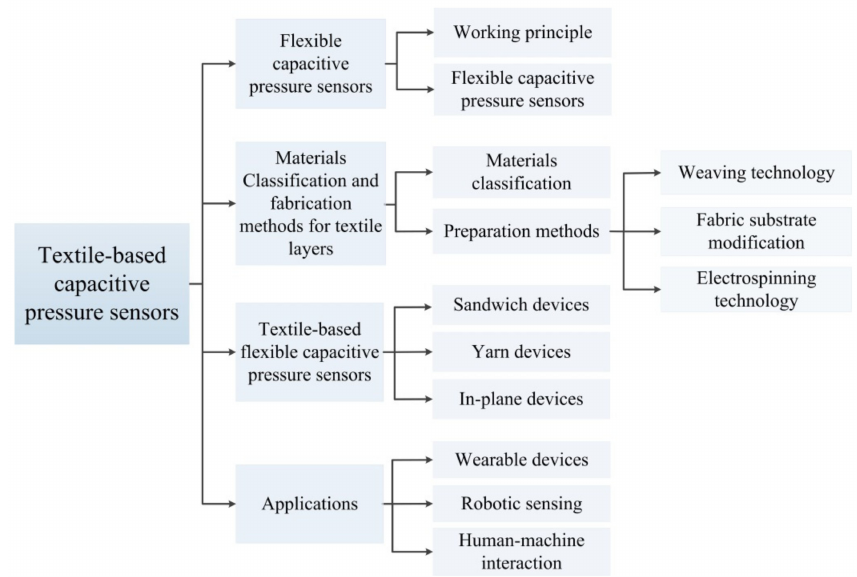
Figure 1. The framework of textile-based capacitive pressure